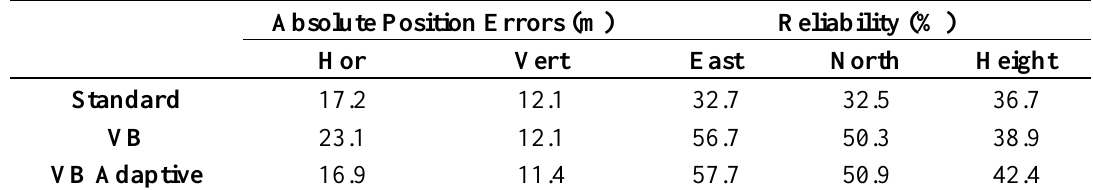
Table 4. RMSE and reliability (OEM6 + IMU)—natural canyon.